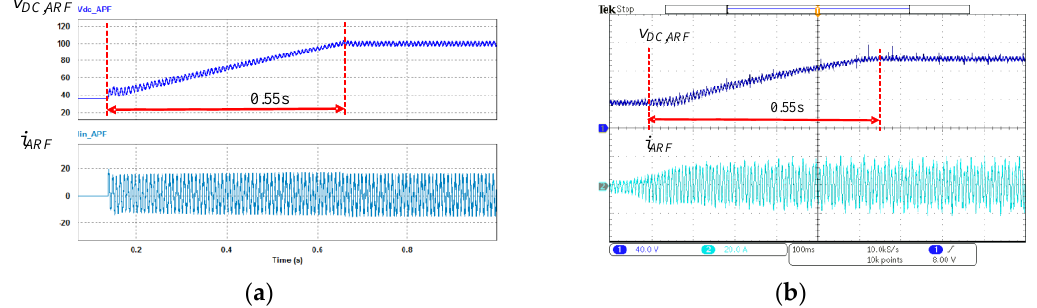
Figure 15. The bus voltage and inductor current of the ARF during the soft start process: ( a ) Simulation result and ( b ) experimental result.